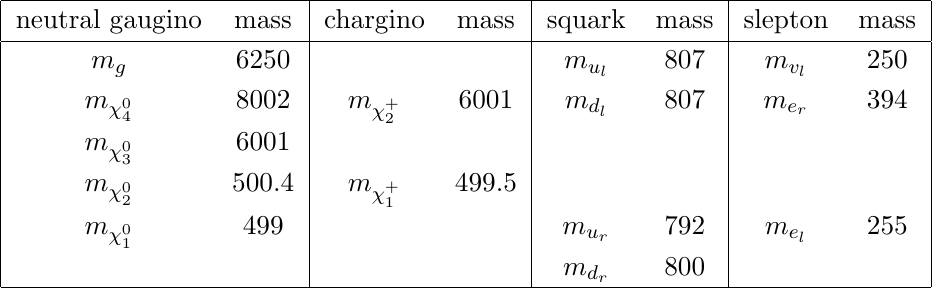
Table 4 . A benchmark spectrum with heavy squarks, and intermediate mass Higgsino and a sneutrino